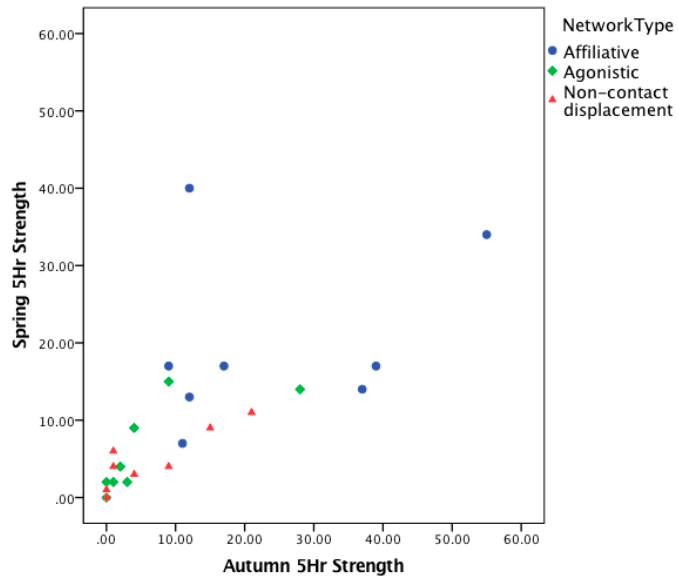
Figure 1. Individual consistency in social behaviour over time. Scatter plot showing adjusted individual elephant’s ( n = 8) strength scores for three different classifications of social interaction (affiliative, agonistic, and non-contact displacement) between two time points (autumn and spring). Strength scores control for differences in amount of time that individuals were in view of the cameras, and represent 5 h of observation for each individual in each sample period.